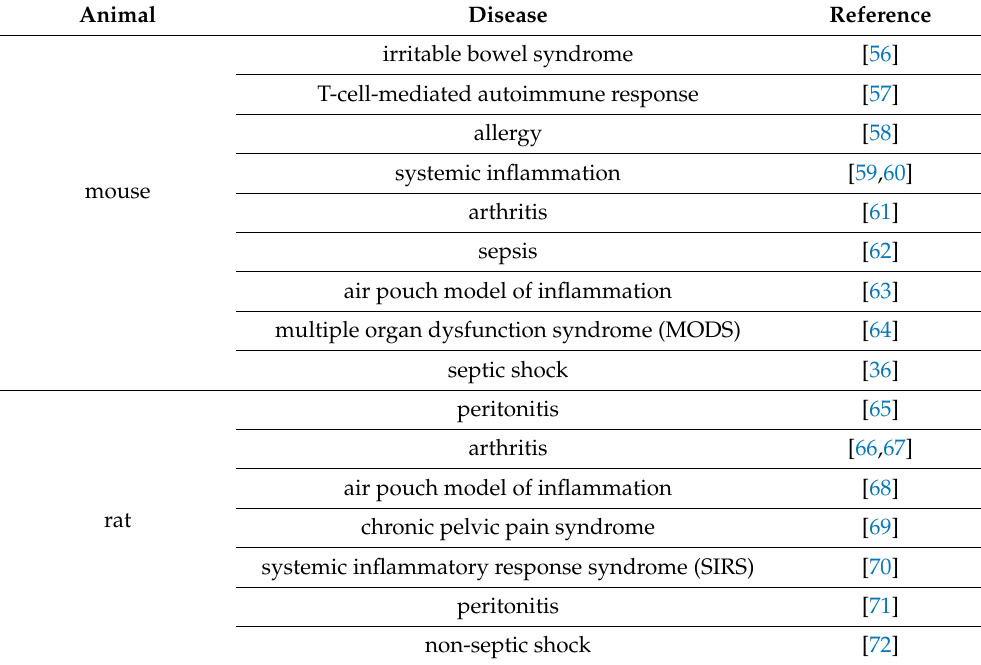
Table 1. Murine models of inflammatory diseases using zymosan as inflammation inducer.